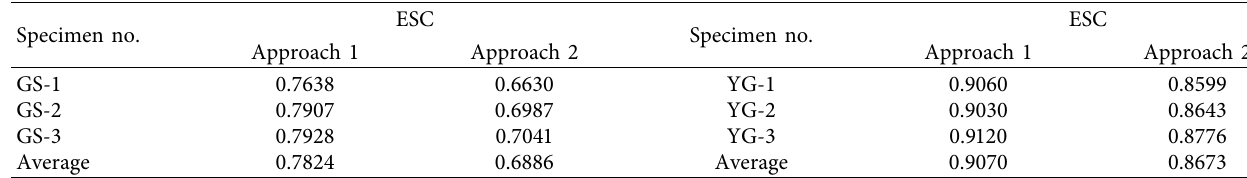
Table 5: Calculation results of ESC with two approaches.